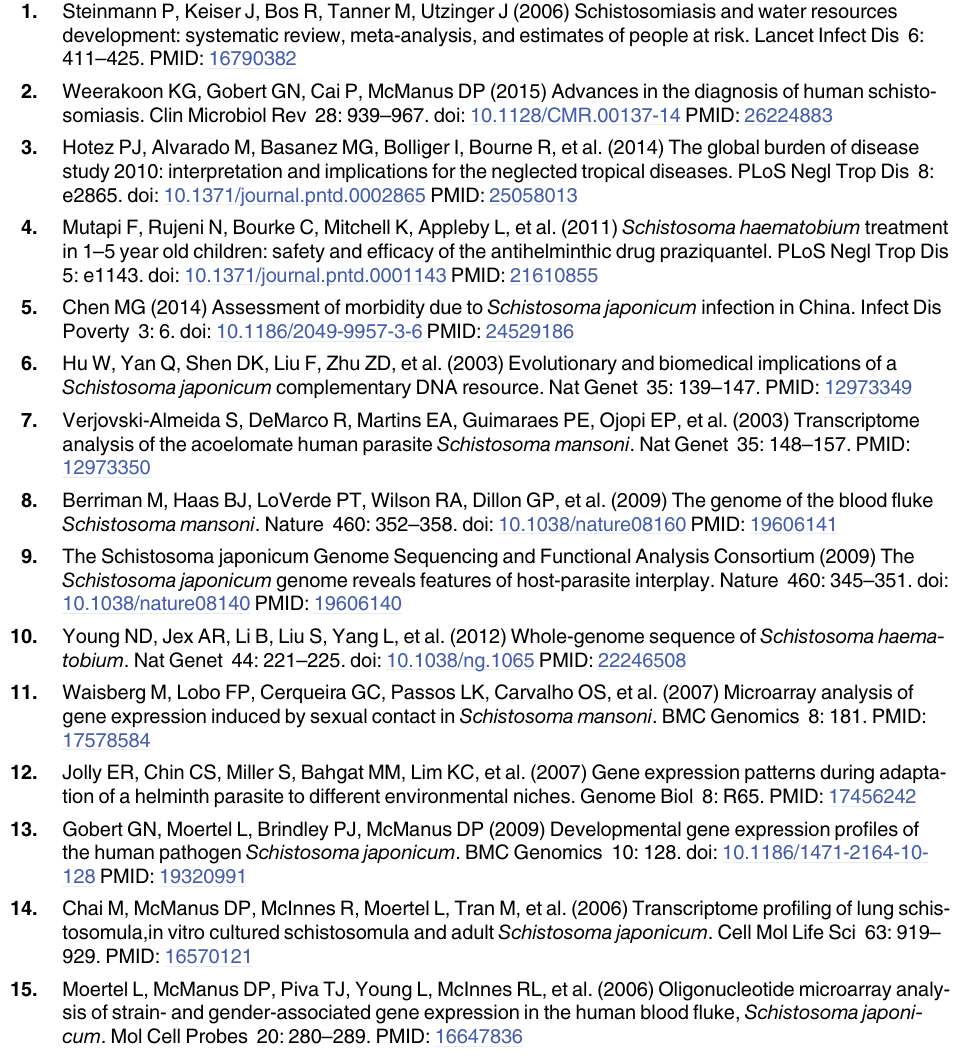
S8 Table. Detailed GO annotation for adult female-biased expressed